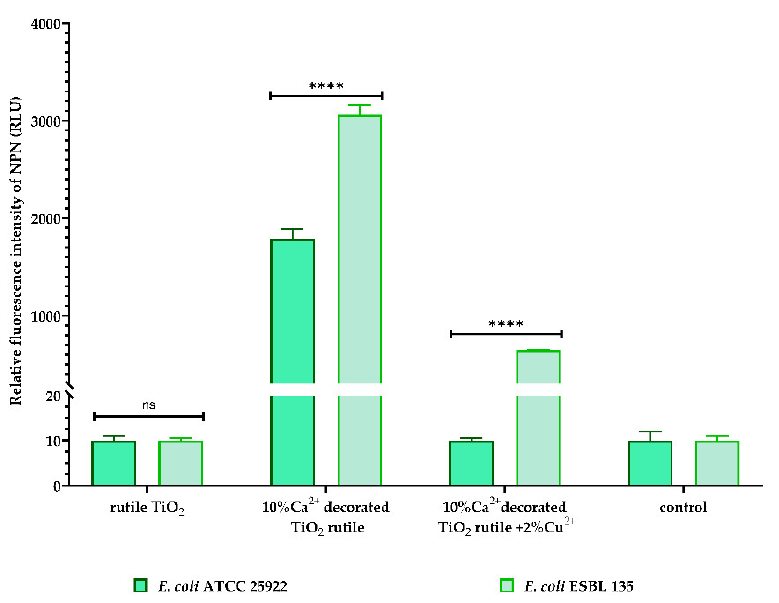
Figure 12. Outer membrane permeabilization of E coli strains measured by detecting the fluorescence intensity of NPN after 30 min of contact with the samples. All the data are shown as the mean ± SD of the three independent experiments. p -values were determined via two-way ANOVA and Dunnett’s multiple comparisons tests (ns—not significant, **** p < 0.0001 vs. untreated control).